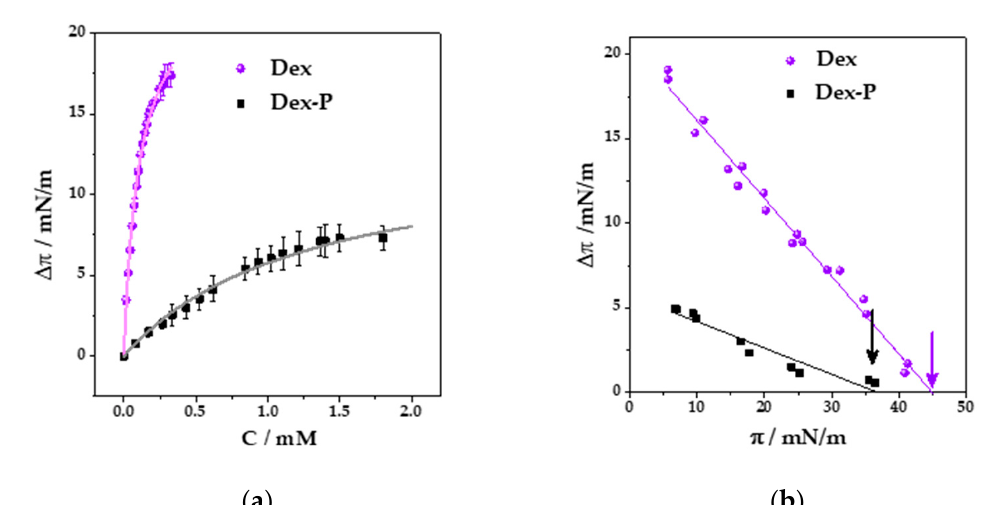
Figure 1. ( a ) Change in surface pressure ∆ π ( π f − π i ) as function of the final drug concentration, film initial pressure 15 mN/m, the straight line corresponds to a hyperbolic fit. ( b ) ∆ π ( π f − π i ) as function of the initial pressure of the DMPC monolayer. Arrows indicate the π cut off values for each drug. Drug final concentration: 0.2 mM Dex (black- square) or 1.2 mM Dex-P. (violet- sphere). Experimental conditions: 150 mM NaCl. T: 20 °C.